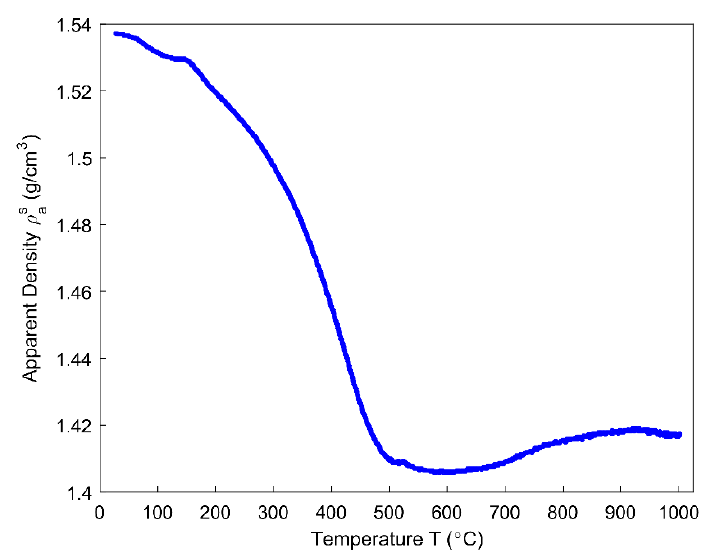
Figure 11. The evolution of apparent density as a function of temperature.